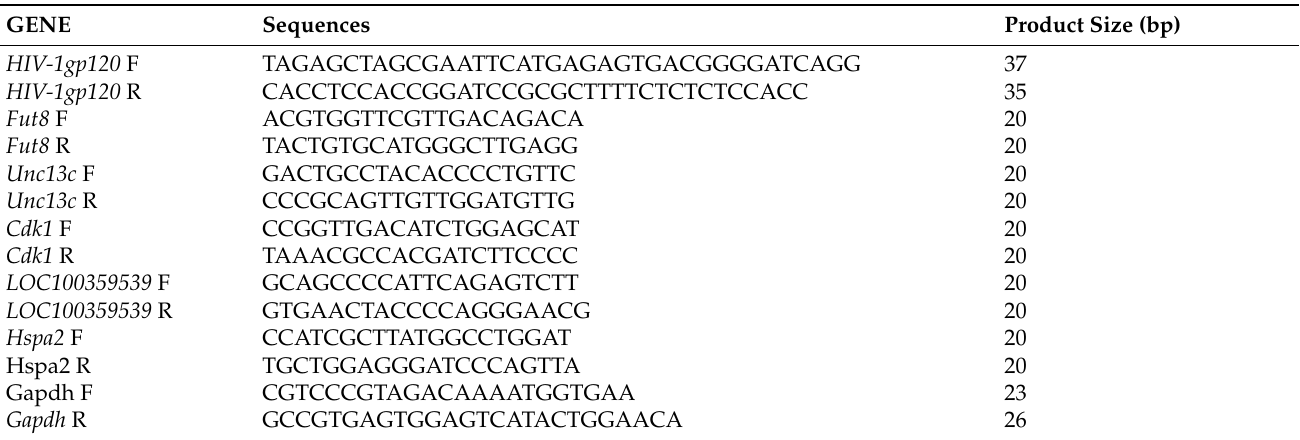
Table 1. Primers used for